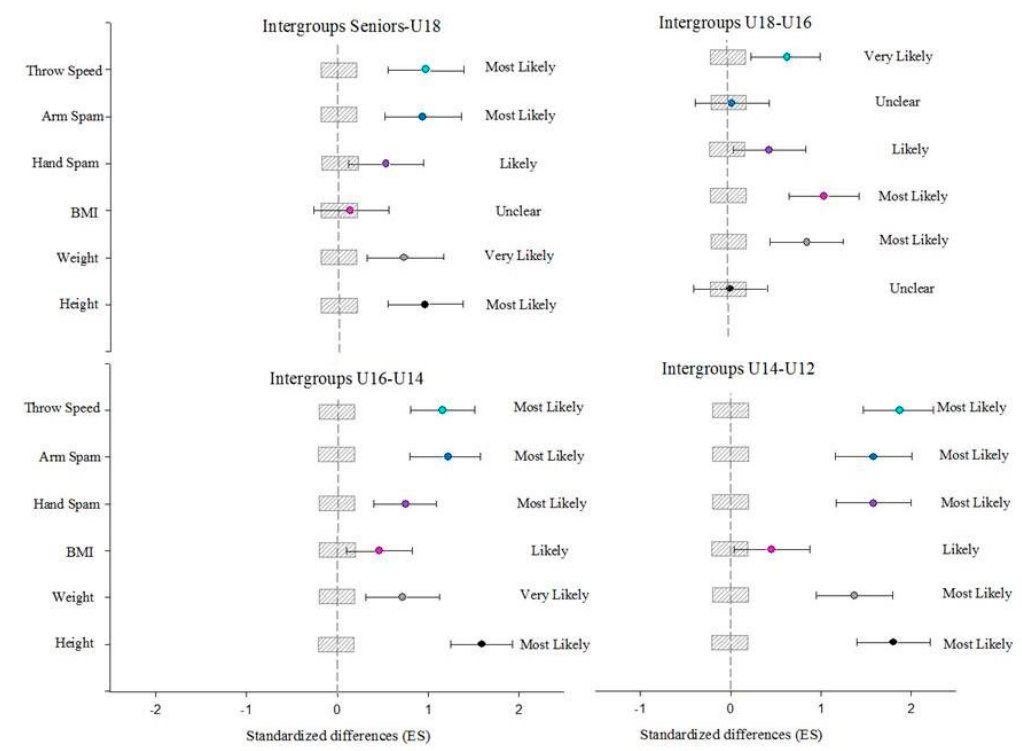
Figure 1. Cohen’s d effect size (ES) between-groups.